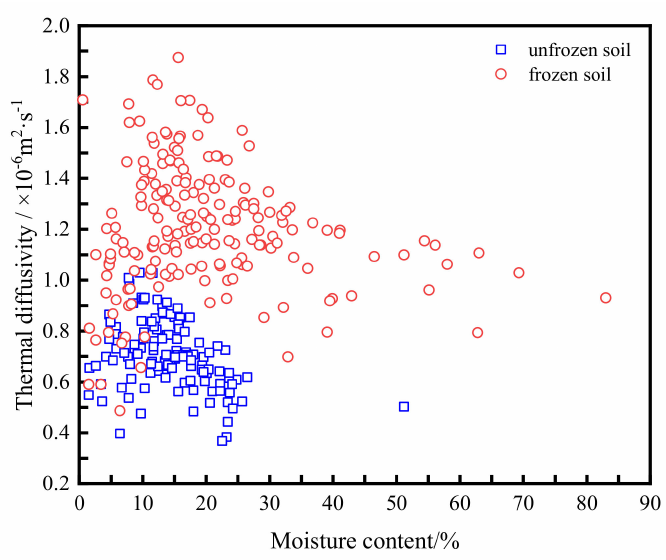
Figure 9. Distribution relationship between moisture content and thermal